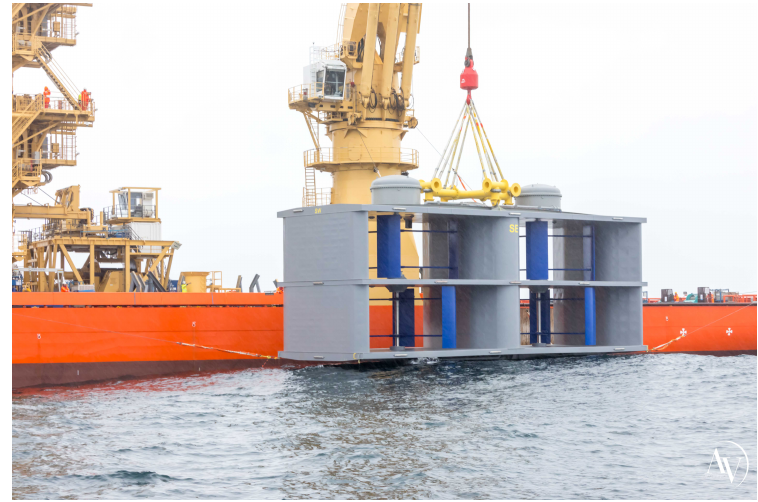
Figure 1. Hydroquest/CMN tidal turbine to be installed at Paimpol-Bréhat test site